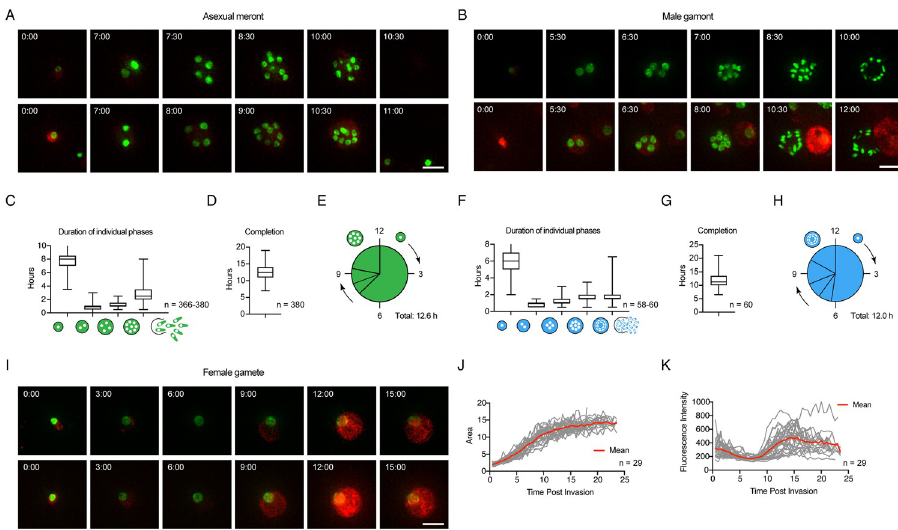
Fig 2. The intracellular development of all stages can be observed in real time in living cells. (A) Images taken from time-lapse microscopy depicting asexual growth and nuclear division, 2 representative meronts. Scale bar: 5 μ m; insets represent hours from time of invasion. (B) Images taken from time-lapse microscopy depicting male parasite growth and nuclear division, 2 representative gamonts. Scale bar: 5 μ m; insets represent hours from time of invasion. (C) Duration of phases of asexual growth. Parasites remain as a single nucleus for an average of 7.92 hours, followed by 0.83 hours as 2 nuclei, 1.11 hours as 4 nuclei, and 2.77 hours as 8 nuclei prior to egress ( n = 366 to 380). (D) Asexual parasites remain intracellular (invasion to egress) for an average of 12.57 hours ( n = 3 80). (E) Graphical representation of the timing of nuclear divisions during asexual development. (F) Duration of phases of male growth. Parasites remain as a single nucleus for an average of 6.28 hours, followed by 0.92 hours as 2 nuclei, 1.07 hours as 4 nuclei, and 1.69 hours as 8 nuclei, and 2.05 hours as 16 nuclei prior to egress ( n = 58 to 60). (G) Male parasites remain intracellular (invasion to egress) for an average of 12.08 hours ( n = 60). (H) Graphical representation of the timing of nuclear divisions during male development. (I) Images taken from time-lapse microscopy depicting female growth, 2 representative gametes. Scale bar: 5 μ m; insets represent hours from time of invasion. (J) Total area of female parasites over time. Gray lines represent individual female parasites, and red line indicates the average area of female parasites over time ( n = 29). (K) Total fluorescent intensity of cytoplasmic mScarlet for the entire area of female parasites over time. Gray lines represent individual female parasites, and red line indicates the average of female parasite over time ( n = 29). Underlying data are provided in the Supporting information as S2